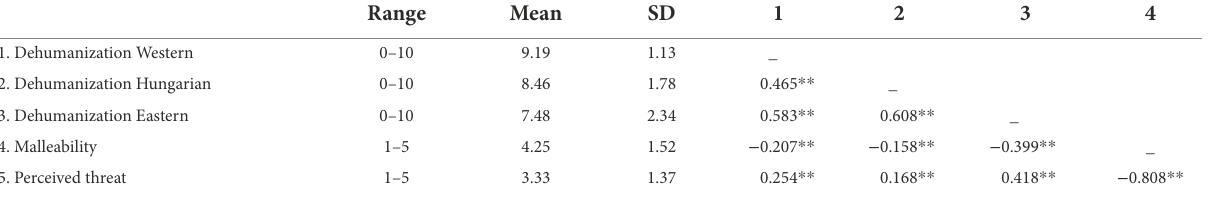
TABLE 1 Descriptive statistics and intercorrelations between the prejudice